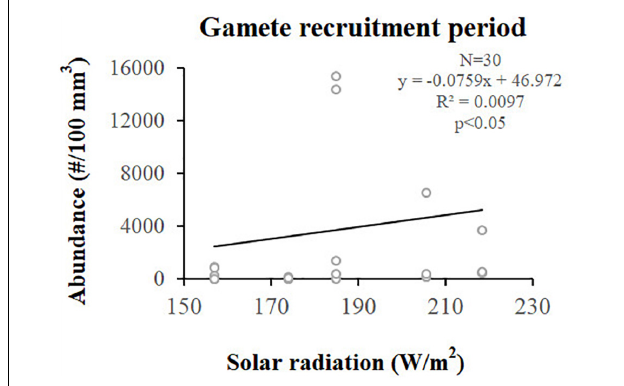
FIGURE 7 | Spermaries. Correlation analysis between spermary abundance and solar radiation (W/m 2 ) for gamete recruitment period. N , polyp number; R 2 , coefficient of determination; p , significance of p -value.